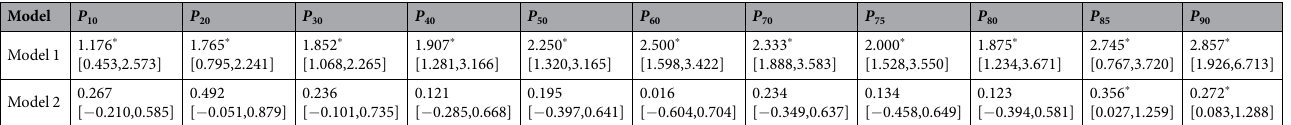
Table 5. Quantile regression coefficients [95% CI ] between FBG and SBP in females. * P < 0.05. CI: confidence interval. Model 1, without adjustments for the confounding factors. Model 2, adjusted for age, BMI, WC, smoking status, alcohol consumption and dyslipidaemia.